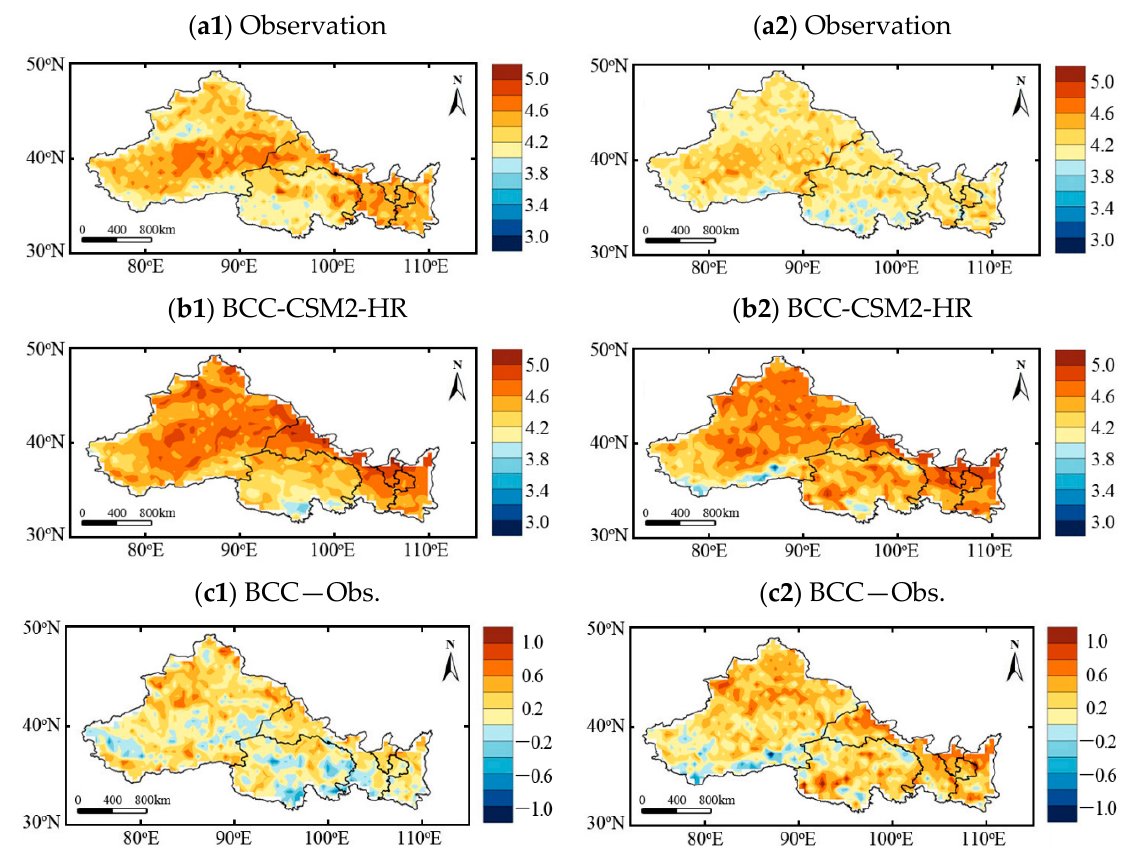
Figure 6. Spatial distribution of TX10p ( left ) and TN10p ( right ) over Northwest China during 1961– 2014: observations, the values simulated by the BCC-CSM2-HR, and the difference between them. Unit: %.